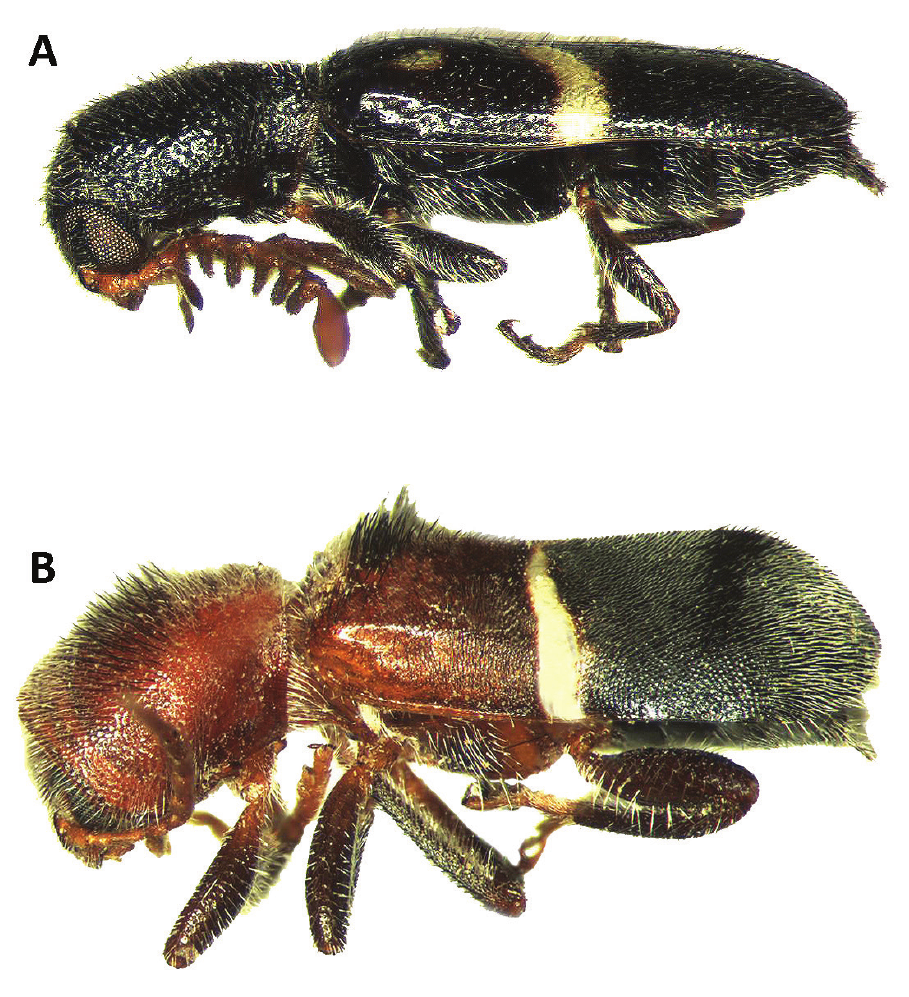
Figure 4. Habitus in lateral view of: A Neocallotillus elegans , male B Callotillus eburneocinctus , male. to the conjointly rounded apices; color black, apical half pale yellow, anterior mar- gin of yellow portion convex; in apical third a large, elongate ovate, common, sutural maculation, extending very nearly to apical margin, black; sides slightly anterior to mid- dle with a feebly arcuate, linear, elevated, white maculation, this extending obliquely and attenuate forward from lateral margin halfway to suture; at basal fourth a minute, slightly transverse, elevated, white maculation midway between the lateral margin and the suture; base with a broad triangular area, having one angle on suture, and an oblique fascia each side, extending from immediately behind the humeri to the suture at a point slightly before the middle, composed of dense, coarse, grayish-white pubescence; a large, feebly elevated, subbasal tubercle, midway between lateral margin and